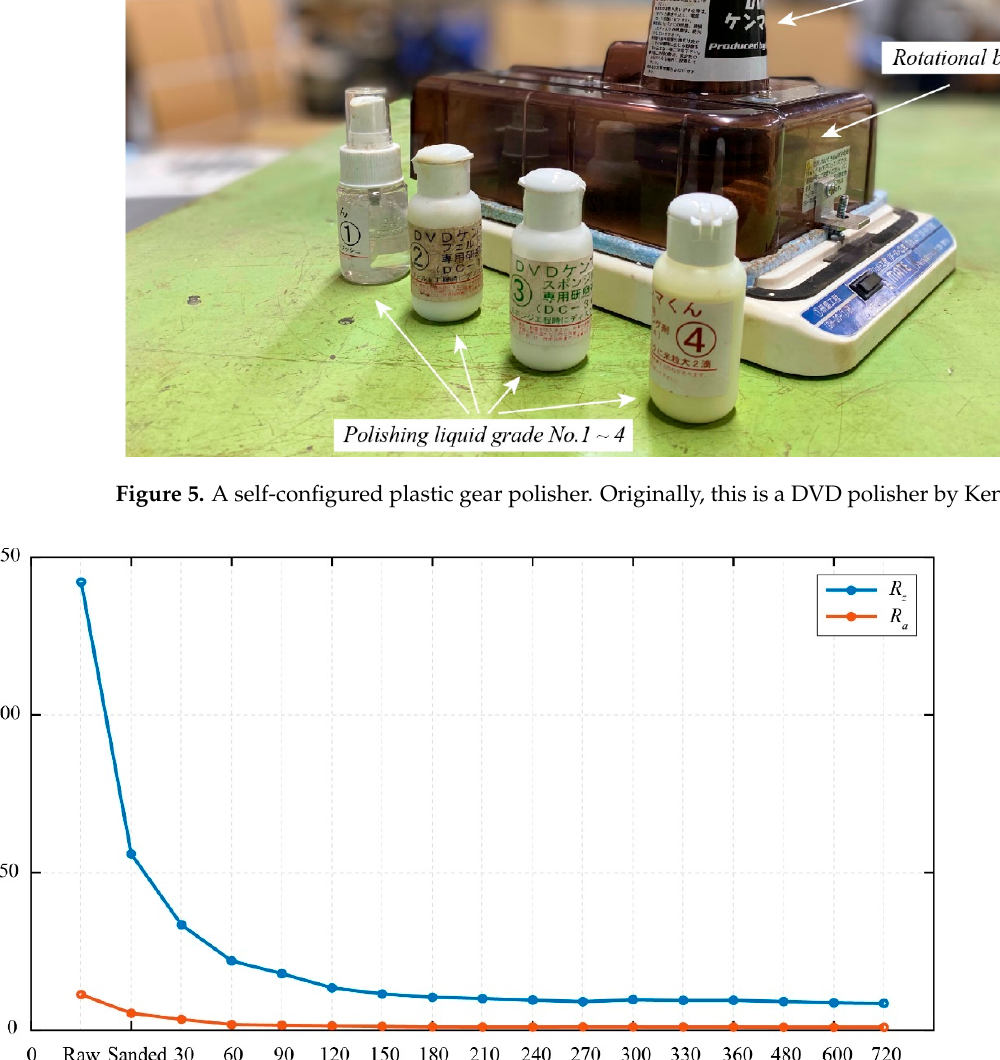
Figure 5. A self-configured plastic gear polisher. Originally, this is a DVD polisher by Kenmac.